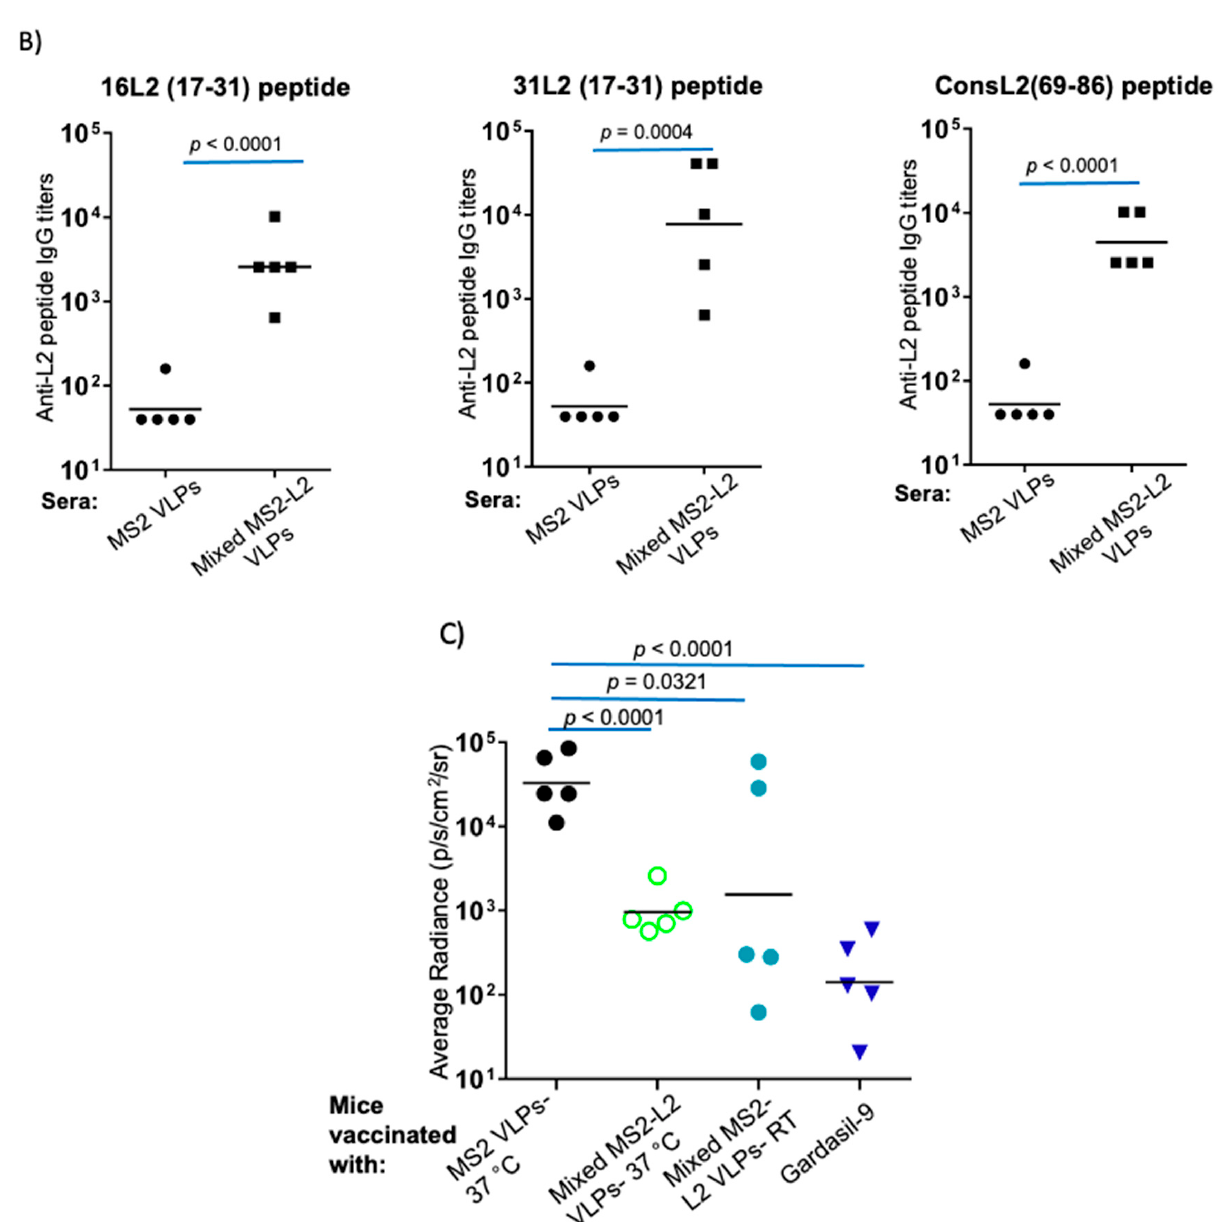
Figure 4. Immunogenicity of SFD-mixed MS2-L2 VLPs and protection from genital infection. Mice were immunized, twice, intramuscularly with 10 µ g of spray-freeze-dried VLPs with alum at two-week intervals. Sera were collected 2 weeks after the last immunization. Anti-L2 peptide IgG titers in sera were determined by end-point dilution ELISA using 16L2 peptide, 31L2 peptide, and consL2 (69-86) peptide as target antigens. The sera were derived from mice immunized with: ( A ) SFD-mixed MS2-L2 VLPs and SFD MS2 VLPs stored at room temperature for 6 months and ( B ) SFD MS2 VLPs and SFD-mixed MS2-L2 VLPs stored at 37 ◦ C for 2 months. Immunized mice in 3A and 3B, including a positive control group, immunized with 10 µ g of Gardasil-9, were genitally challenged with 6.4 × 10 6 infectious units of HPV PsV6 ( C ). Each datum represents the average radiance of an individual mouse, and the lines represent the geometric mean for each group of mice. The p -values were determined by an unpaired two-tailed t -test for Figure 4A,B and an unpaired one-tailed t -test for Figure 4C.